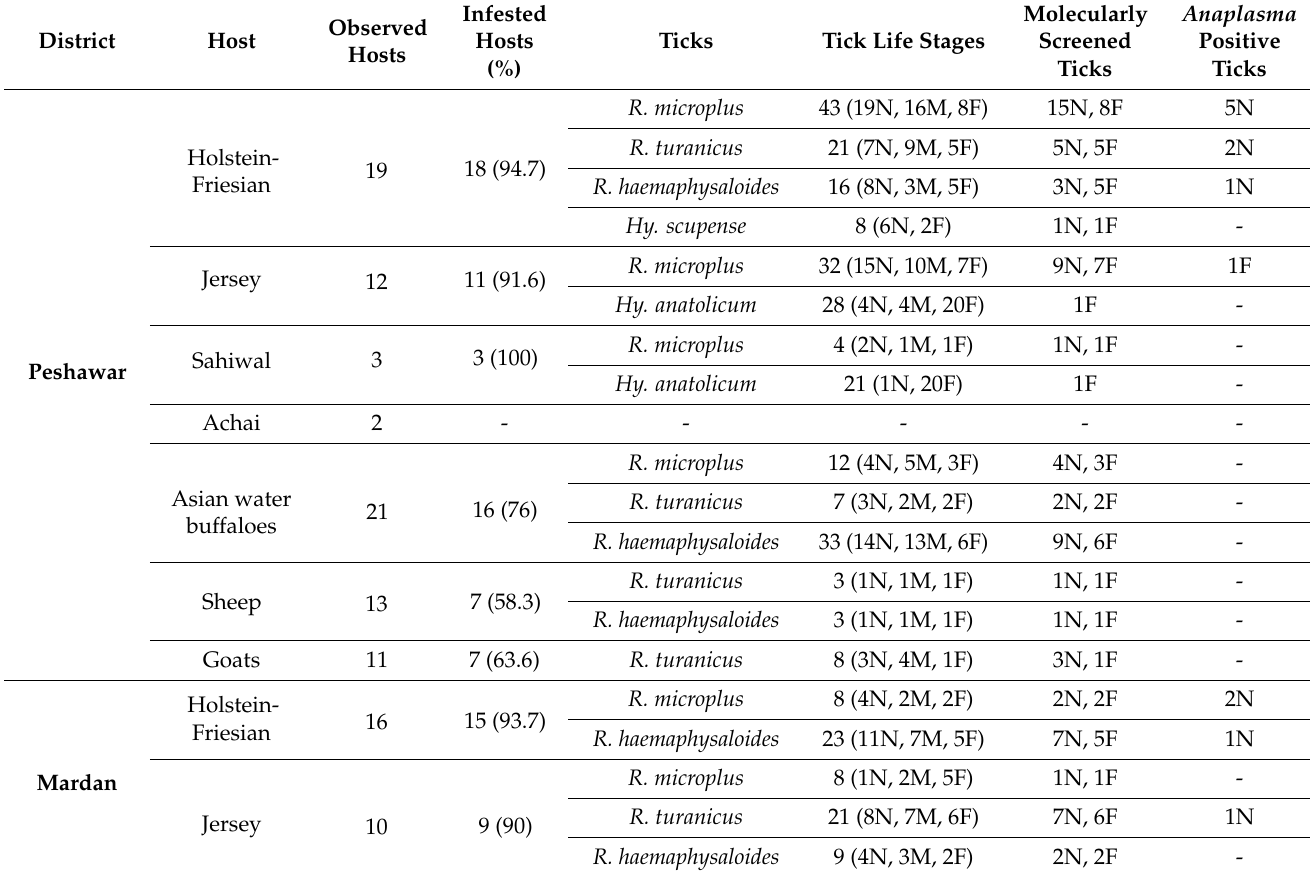
Table 1. Occurrence of ticks in various hosts and molecular detection of Anaplasma marginale in different districts of Khyber Pakhtunkhwa,